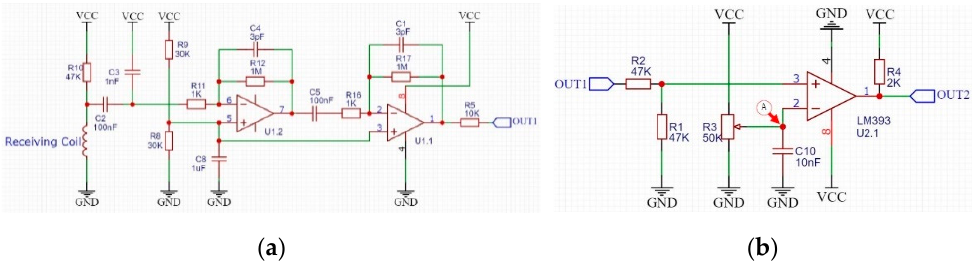
Figure 10. Signal amplifier circuit and first comparator circuit: ( a ) signal amplifier circuit and its output: OUT1; ( b ) first comparator circuit and its output: OUT2.